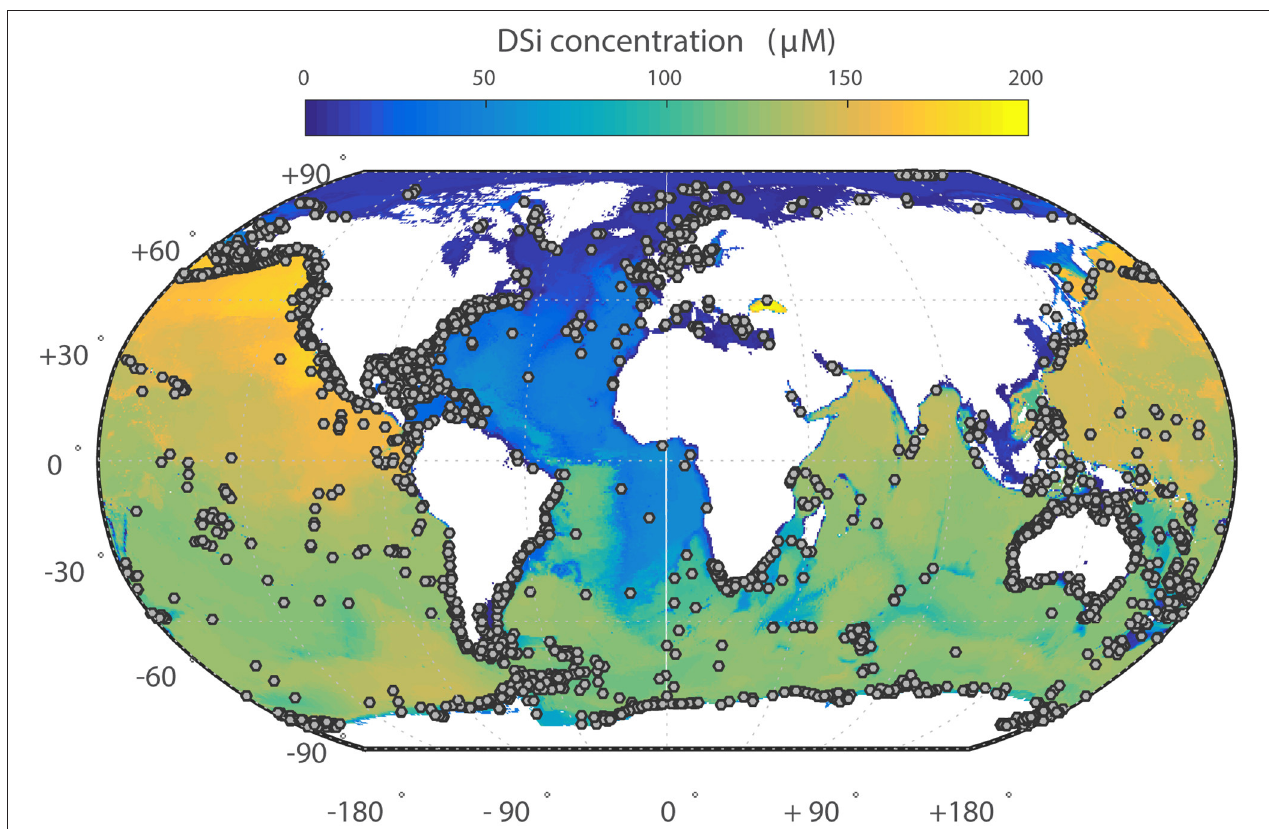
FIGURE 1 | Ocean dissolved silica concentrations in bottom waters (i.e., seafloor). Gray dots indicate the location of individual sponge records included in this manuscript from